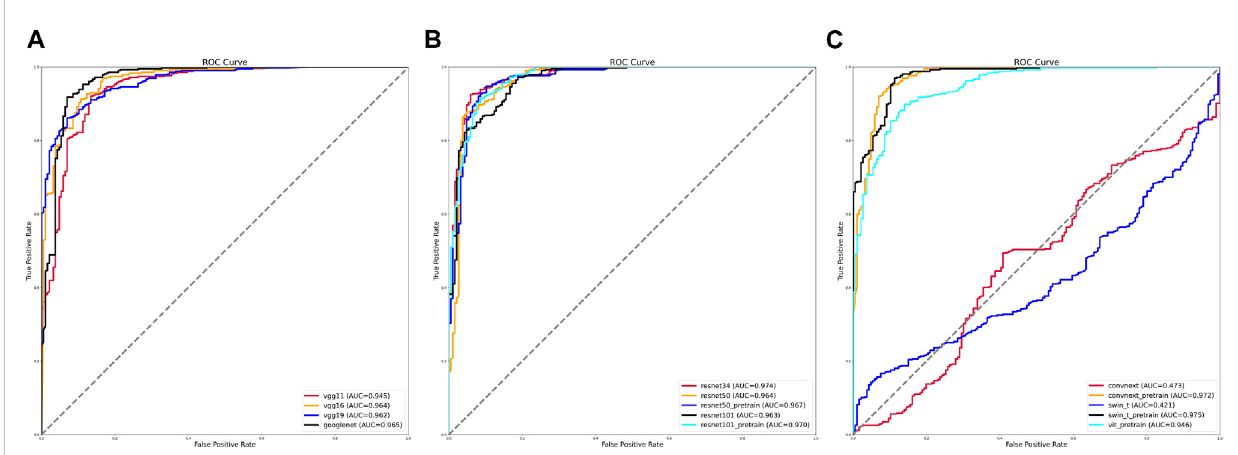
FIGURE 1 Receiver operating characteristic (ROC) curves and area under thecurve (AUC) values of various training models. (A) ROC curves and AUC values of VGG and GoogLeNet training models. (B) ROC curves and AUC values of ResNet training models before and after using pretrained weights. (C) ROC curves and AUC values of ViT, Swin-T, and ConvNeXt training models before and after using pretrained